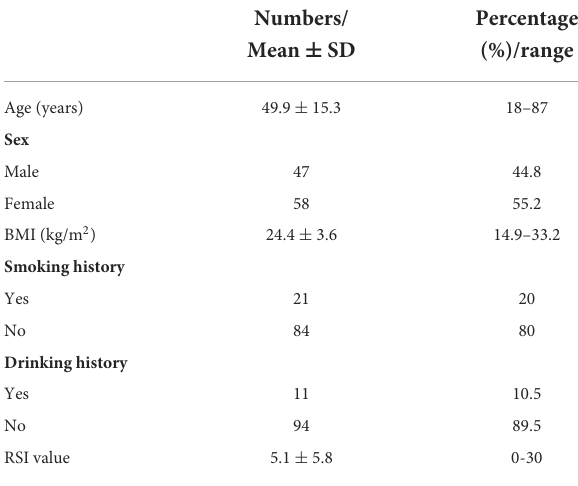
TABLE 1 The baseline information of the 105 newly diagnosed OME